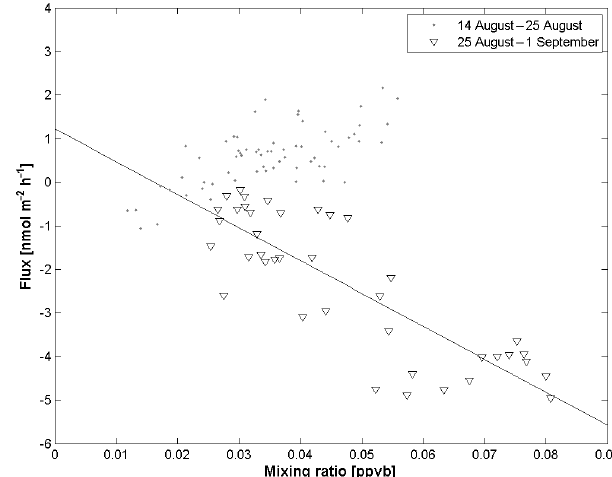
Figure 5. Example of benzaldehyde daily pattern for a day when benzaldehyde emission was detected. Measurements correspond to three different red oak upper-canopy branches.